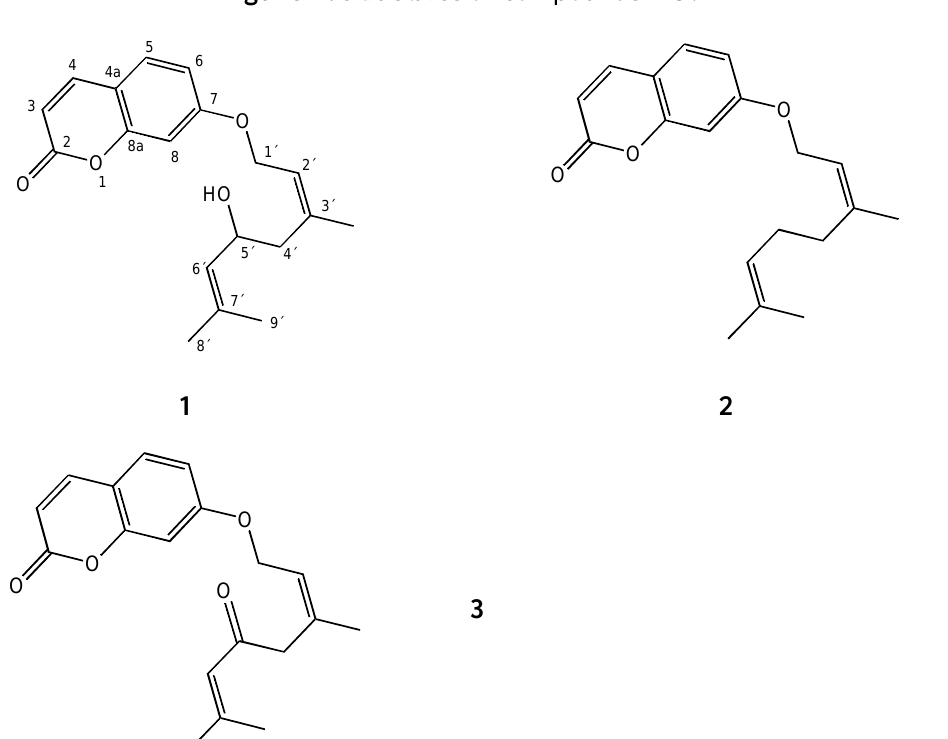
Figure 1. Structures of compounds 1-3